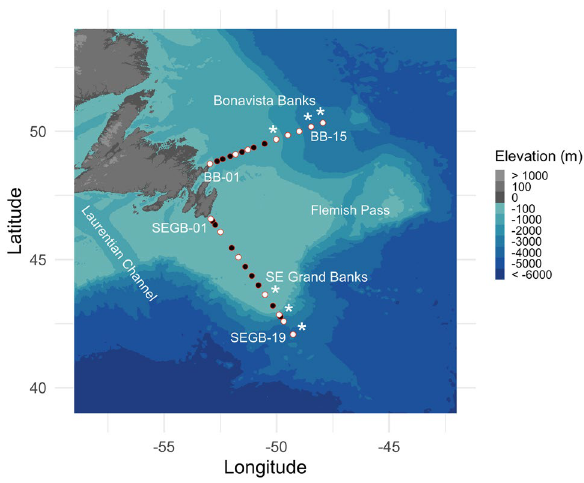
Figure 1. The Bonavista Banks (BB) and SE Grand Banks (SEGB) sampling transects. Stations (white and black) contain full CTD profiles, white dots indicate Niskin bottle samples for DNA and imaging at 5 m, and the asterisks indicate additional Niskin samples from 20 and 50 m. Note that the ship did not sample every original station, but original station names are kept here, thus SEGB-19 was the 15 th station sampled at the SE Grand Banks. Maps were generated using the marmap R package (v. 1.0.6) 82